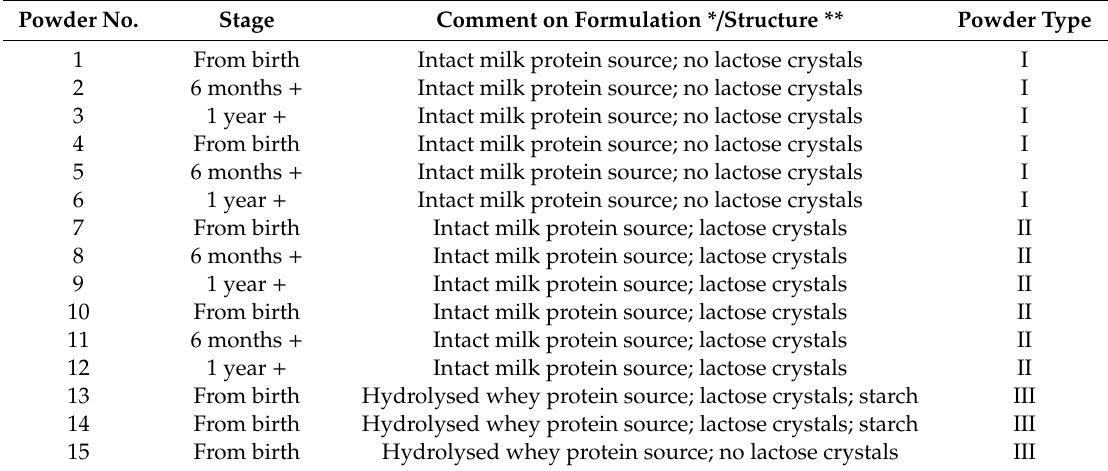
Table 1. Information on powders used in